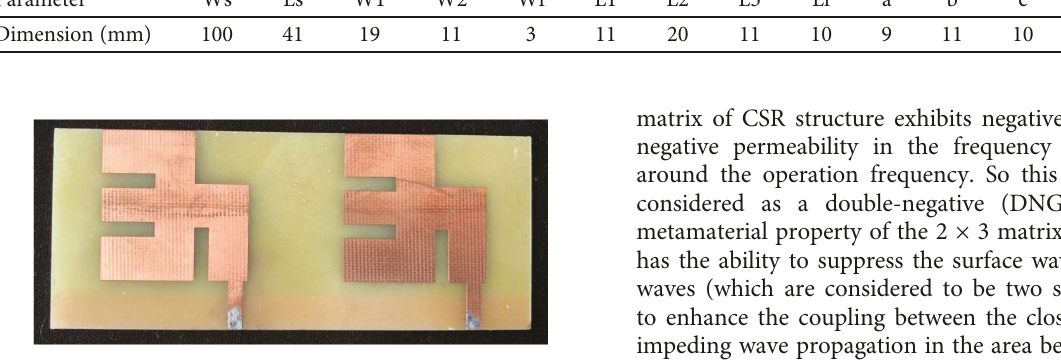
Figure 2: Fabricated